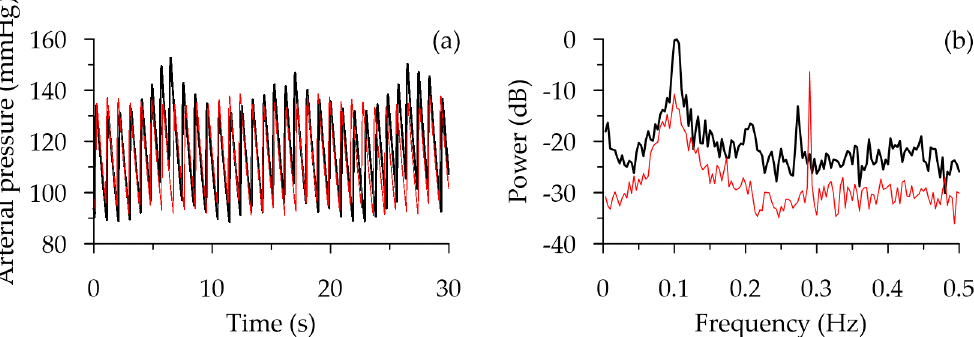
Figure 2. Time series ( a ) and Fourier power spectra ( b ) for the model RR intervals. The black bold lines correspond to a healthy subject, and the red thin lines correspond to the simulation of the blockade of the regulation of respiratory amplitude and frequency.